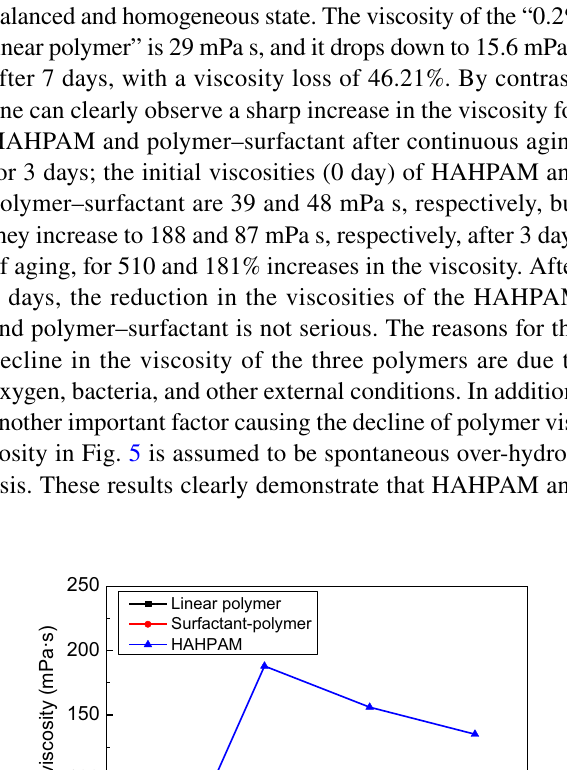
Fig. 4 Apparent viscosity plotted as a function of concentrations for HAHPAM, surfactant–polymer, and linear polymer in brine (salin- ity = 9000 mg L −1 , [Ca 2+ ] + [Mg 2+ ] = 900 mg L −1 , T = 65 °C, concen- trations vary from 0.05 to 0.2 wt%, ̇𝛾 = 7.34 s −1 )